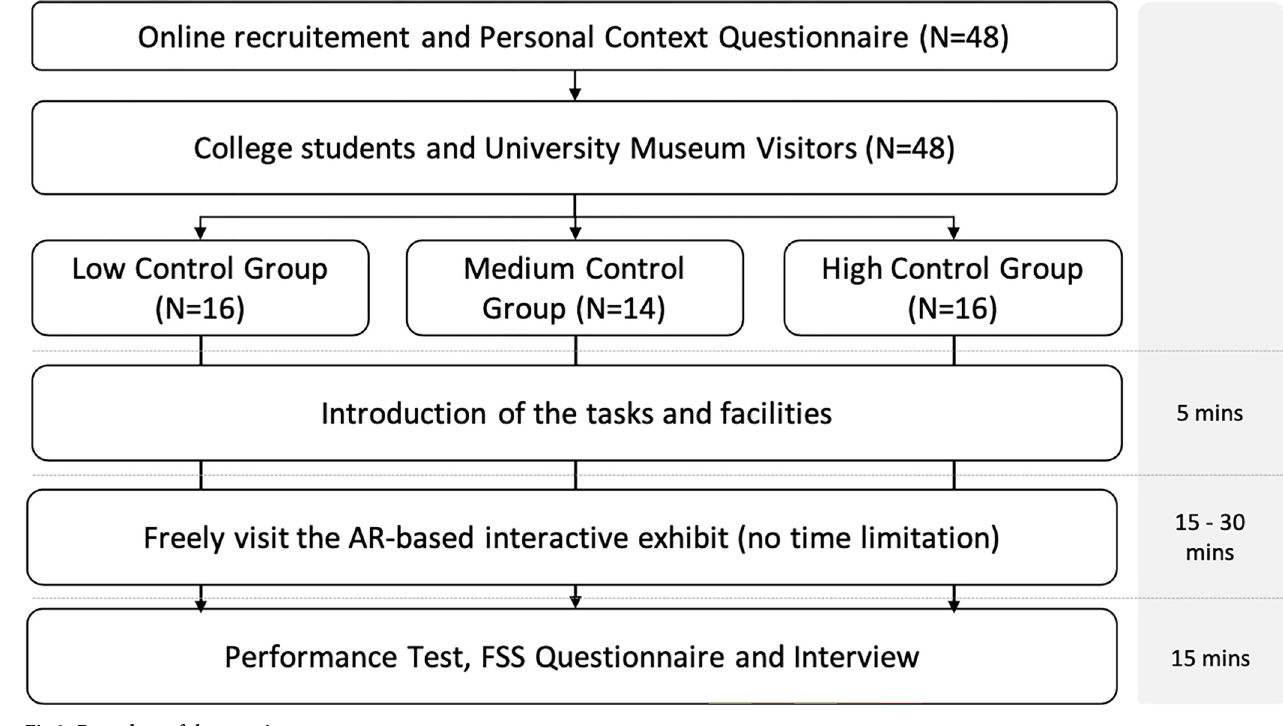
Fig 3. Procedure of the experiment.